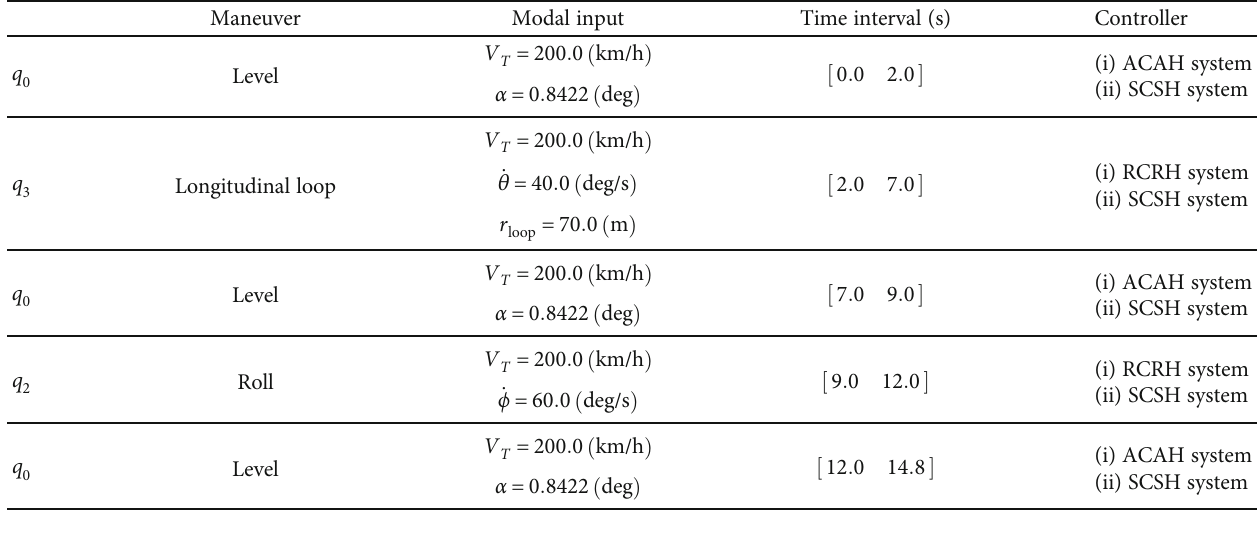
Table 7: Immelmann-turn